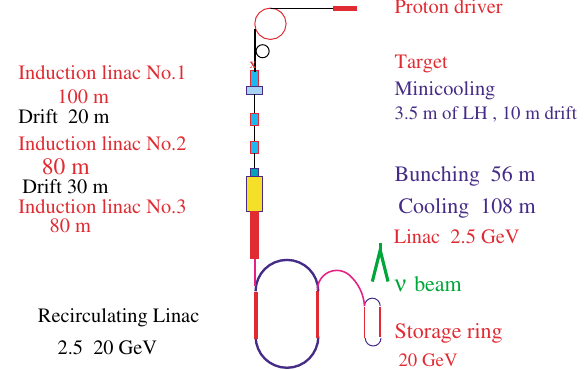
FIG. 2. (Color) Schematic of the neutrino factory study-II